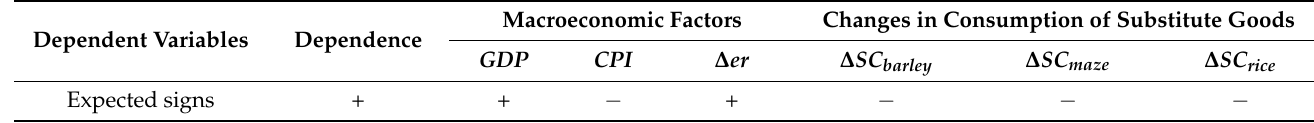
Table 1. Assumptions on panel analysis